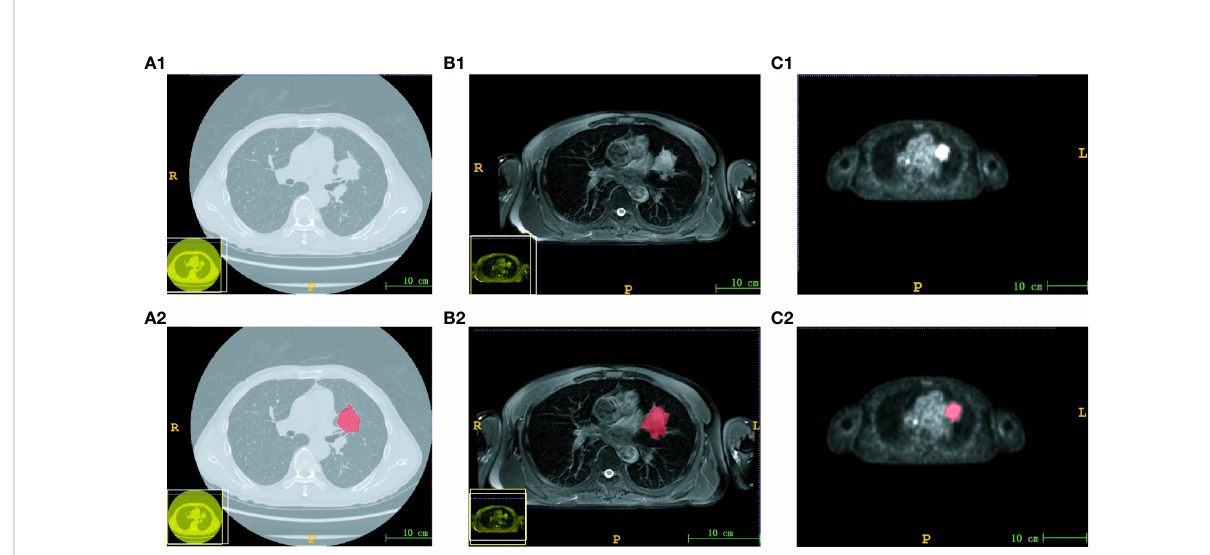
FIGURE 1 Images and corresponding ROI of three modalities. The original image of CT (A1) , MRI (B1) and PET (C1) . The ROI image of CT (A2) , MRI (B2) and PET (C2) . The scale bar was 10